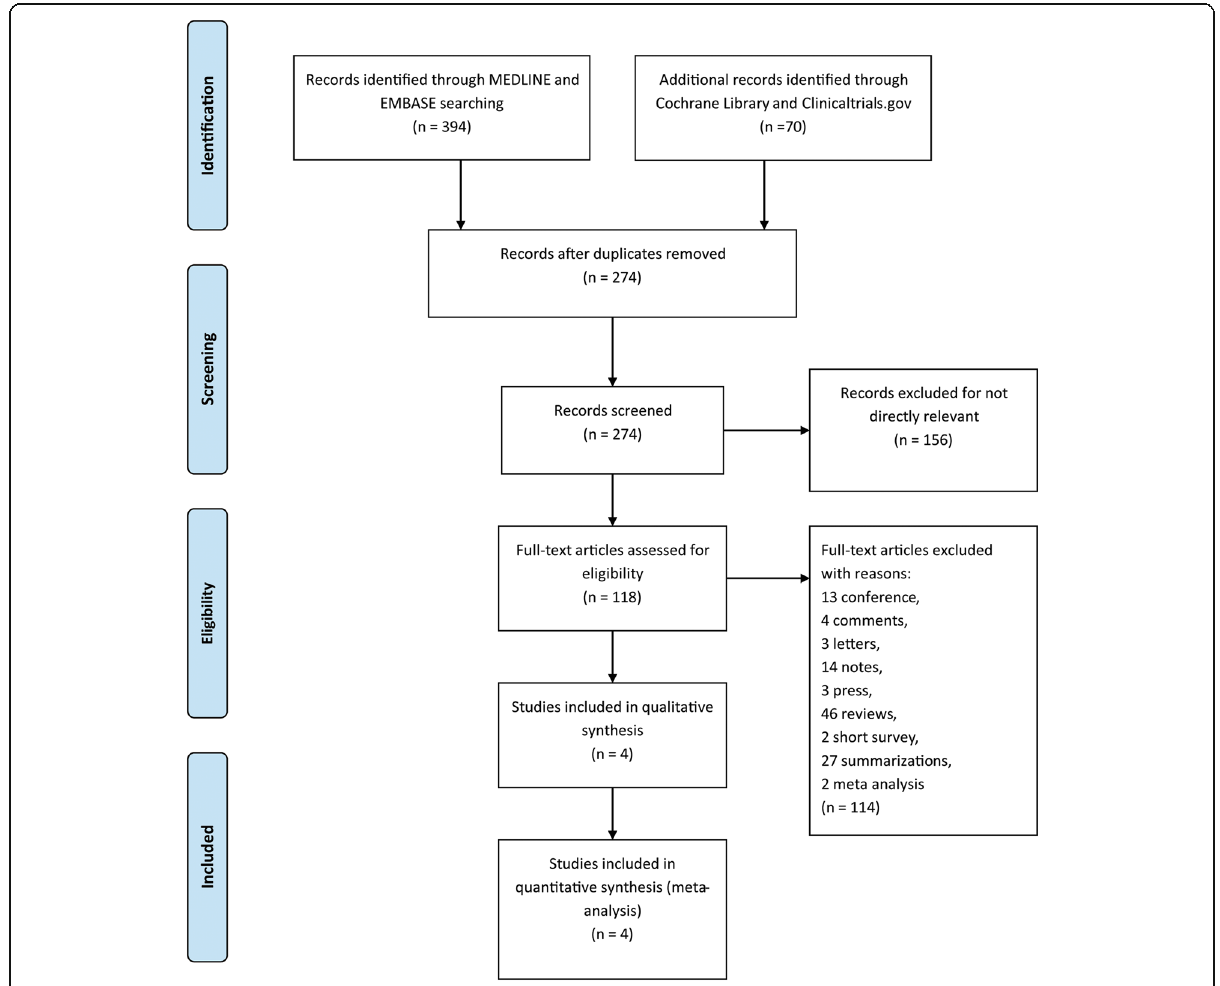
Fig. 1 The study search, selection and inclusion